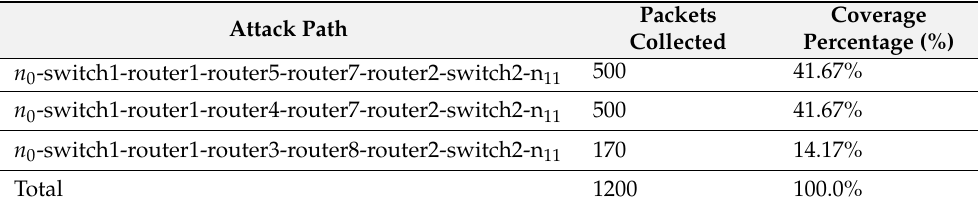
Table 4. Possible paths of DDoS attacks (number of nodes = 32, array ( x , y ), w =